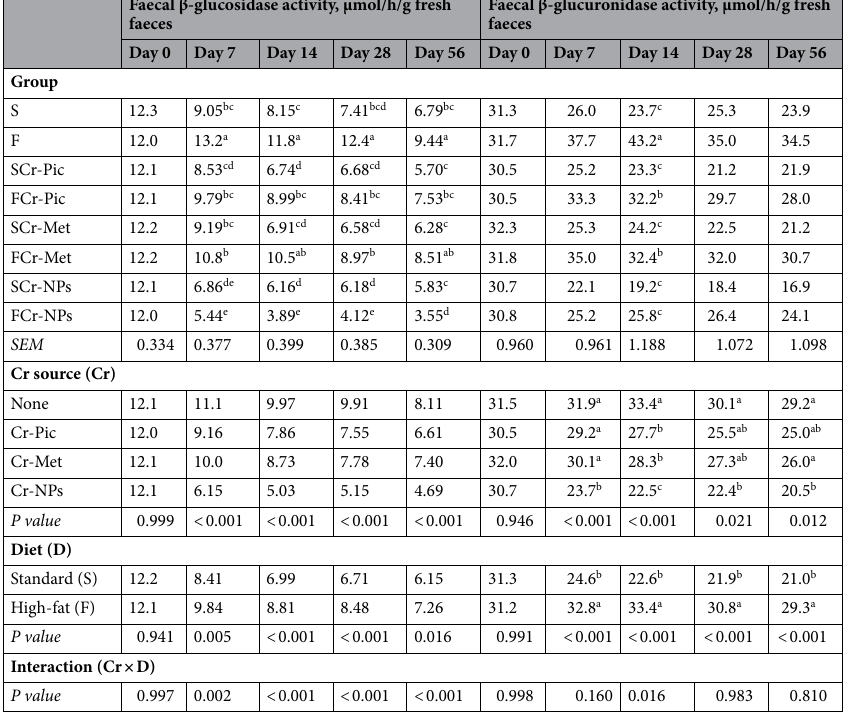
Table 4. Faecal extracellular bacterial β-glucosidase and β-glucuronidase activity throughout the feeding period in rats fed experimental diets 1 . S—rats fed a standard diet; F—rats fed a high-fat, low-fibre